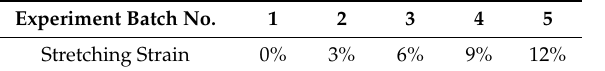
Table 2. Critical strain and roughness of samples.